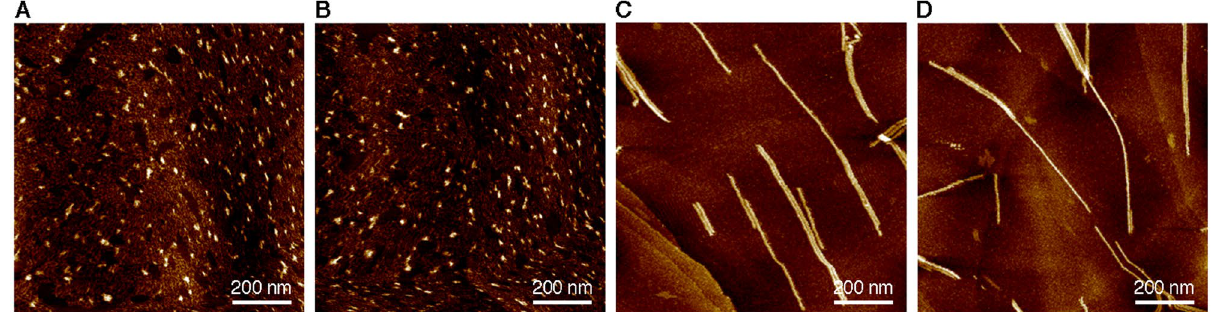
Figure 6. AFM images of two-component 5 / 6 self-assembly. AFM images (HOPG substrate) of ( A , B ) metastable two-component 5 / 6 J aggregates and ( C , D ) coassembled 5 / 6 H aggregates obtained after time-